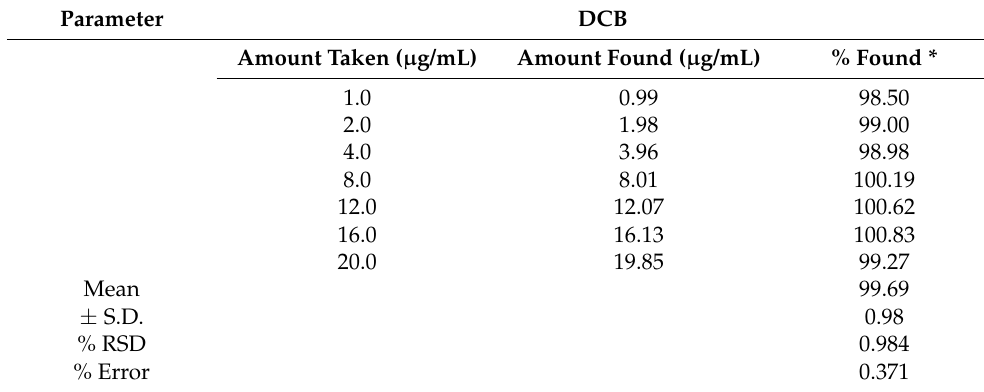
Table 2. Accuracy data of the designed method for the determination of DCB in pure form.